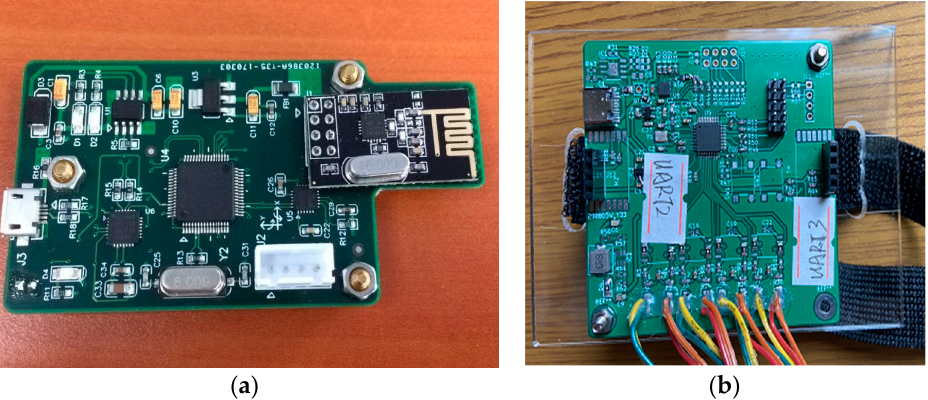
Figure 3. Motion Information Collection Module. ( a ) Waist information acquisition module; ( b ) heel and foot information acquisition module.